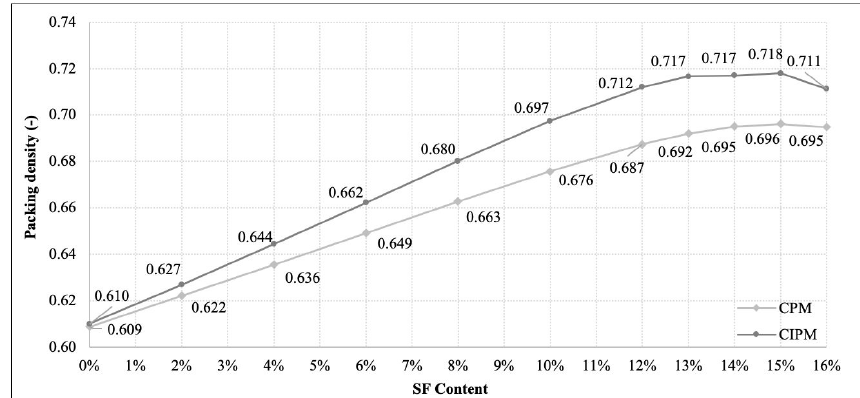
Figure 7. Packing densities of the PC, SP and SF combinations using the CPM 34 and CIPM 18,35